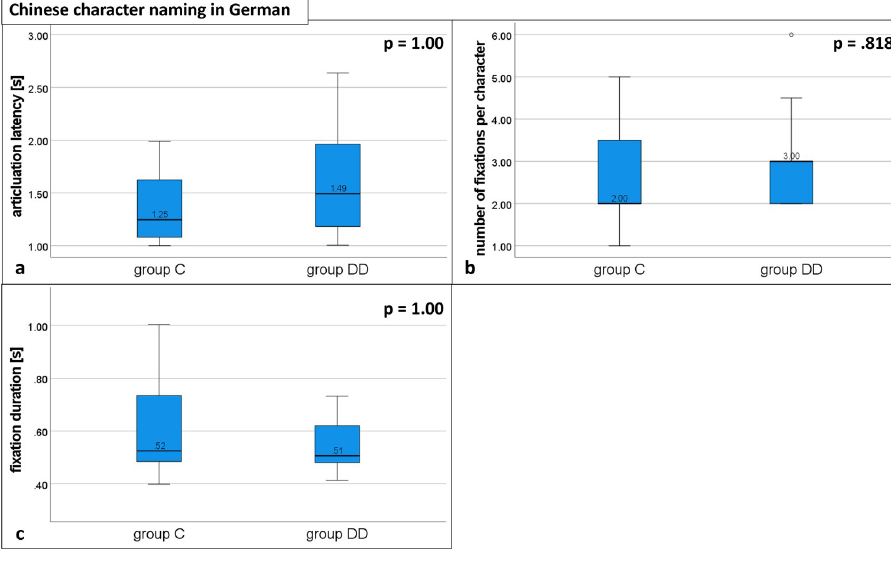
Fig 5. Eye movement variables during naming Chinese characters in German. Distribution of group DD and group C. Medians for a) articulation latency, b) number of fixations, and c) fixation duration; p = probability value. No statistically significant differences. See Table 2 for